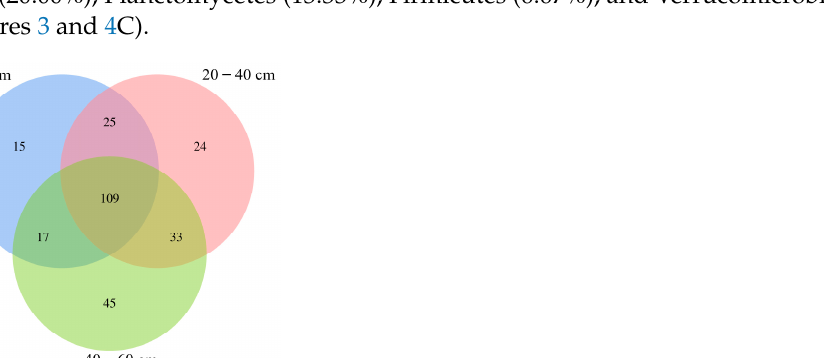
Figure 3. Topological role distribution of bacterial molecular ecological network nodes in three soil layers. Figure 4. Distribution pa tt erns of key phylum in topsoil ( A ), middle layer ( B ), and subsoil ( C ) of native tree plantation. 3.4. Functions of Soil Physicochemical Characteristics in Bacterial Molecular Ecological Network Structure From the view of the module hierarchy among the bacterial molecular ecological net- works in each soil layer, modules 1 and 3 were closely related; modules 5 and 6 were closely related; modules 4, 7, and 8 were closely related; and module 2 was di ff erent from the other modules in the topsoil (Figure 5(A1)). Modules 2, 4, and 7 were closely linked; modules 1 and 5 were closely linked; and modules 3 and 6 were closely linked in the mid- dle layer (Figure 5(B1)). Modules 2 and 5 were closely connected; modules 3, 4, and 6 were closely connected; and module 1 was distinctly di ff erent from the other modules in the subsoil (Figure 5(C1)). The e ff ects of physicochemical characteristics of soil on bacterial molecular ecological network structure were di ff erent among di ff erent soil layers. In the topsoil, NH4 + -N